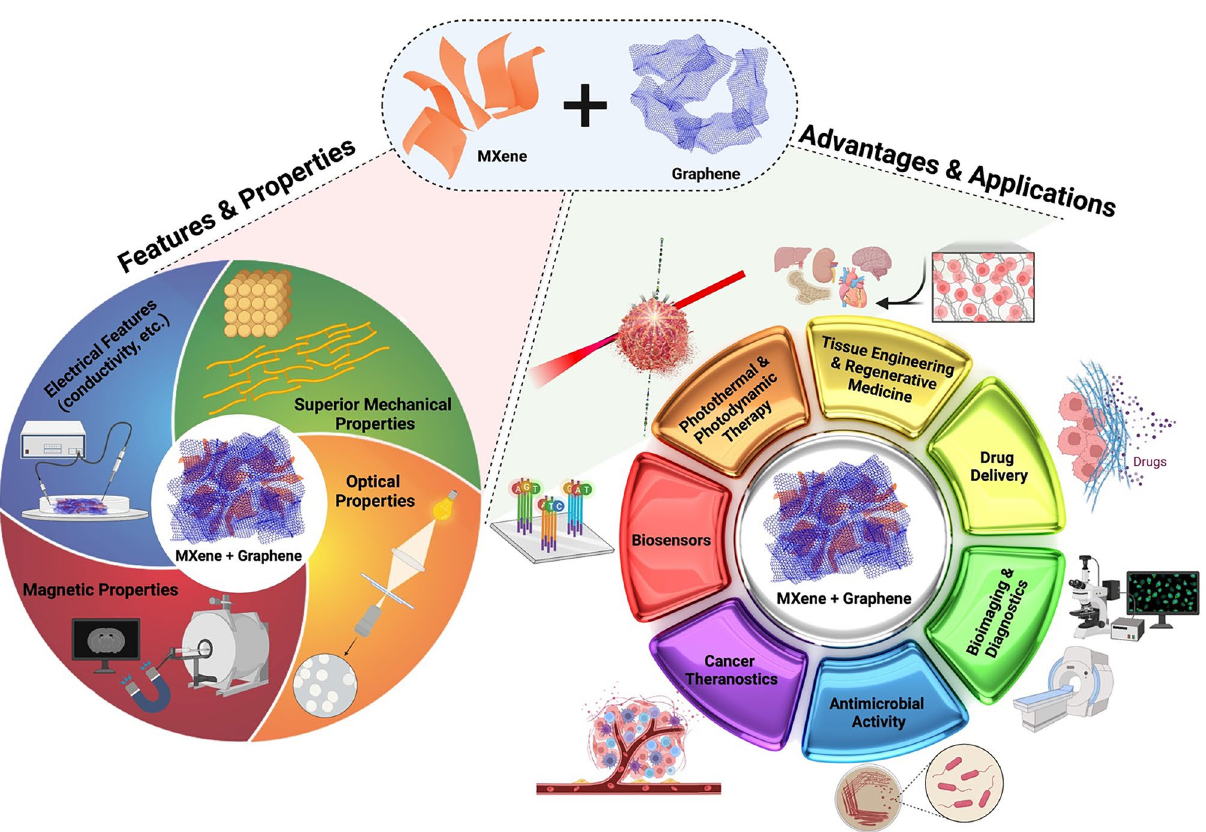
Fig. 1 MXene-graphene hybrids with fascinating physicochemical properties/features can be considered as promising candidates for biomedical